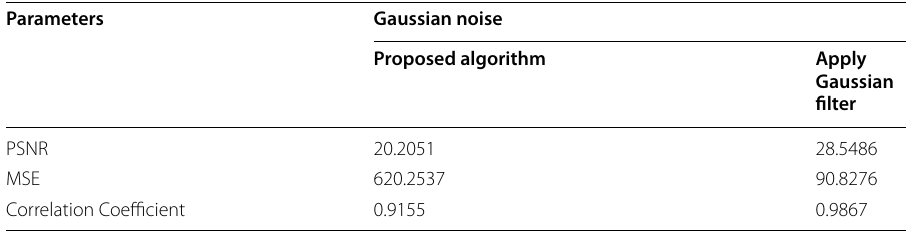
Table 7 Gaussian noise with Gaussian filter